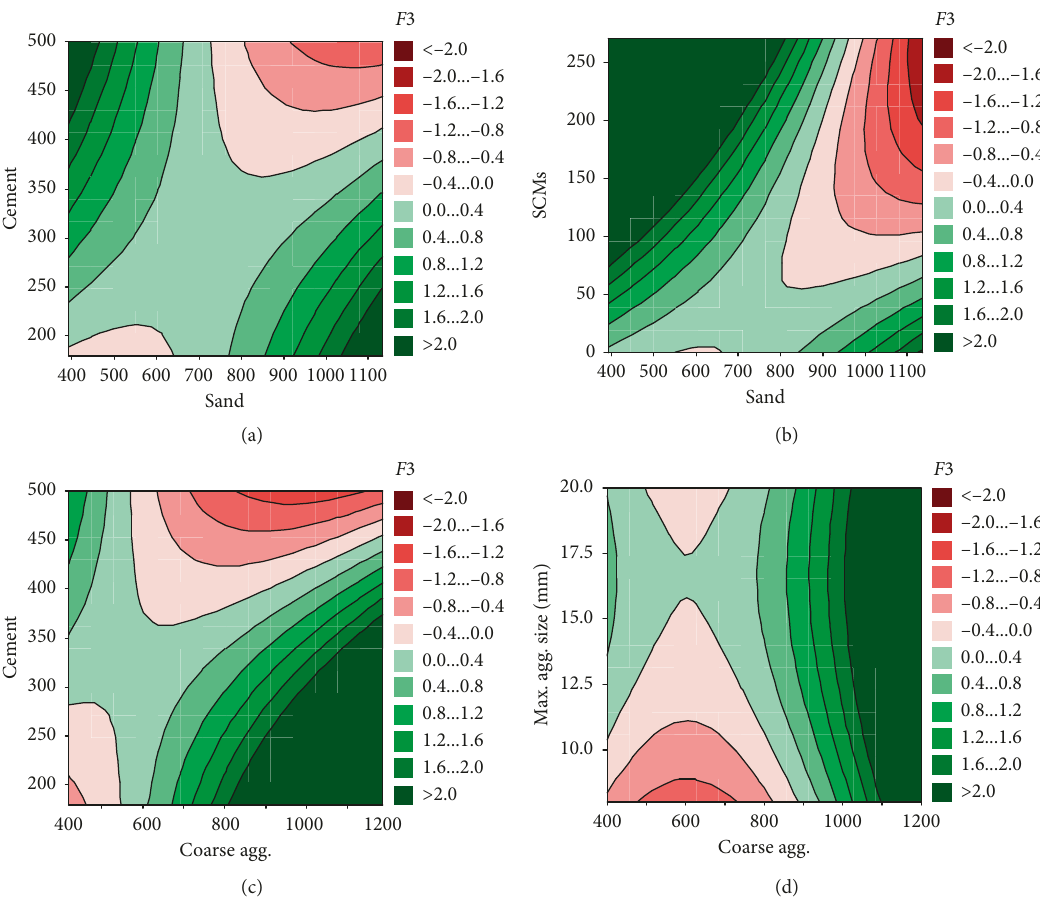
Figure 8: Effect of the dosage of aggregates and powders on the mix stability ( F